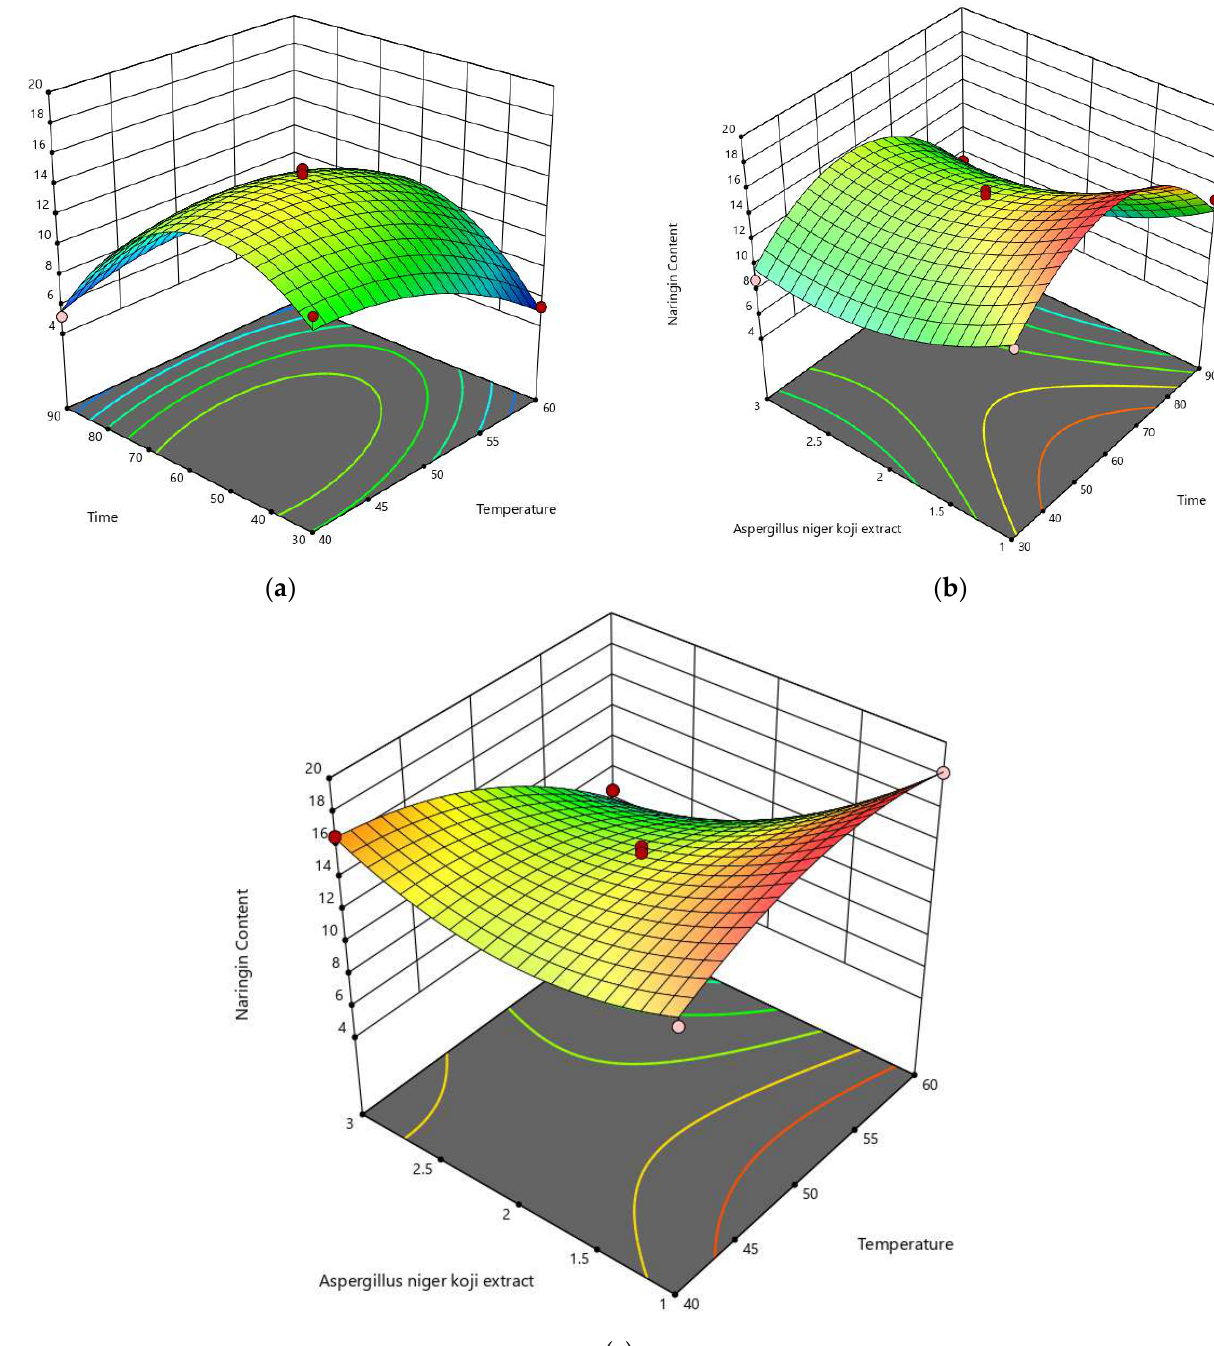
Figure 2. Three-dimensional response surface plots for naringin content as affected by processing parameters ( a – c ).